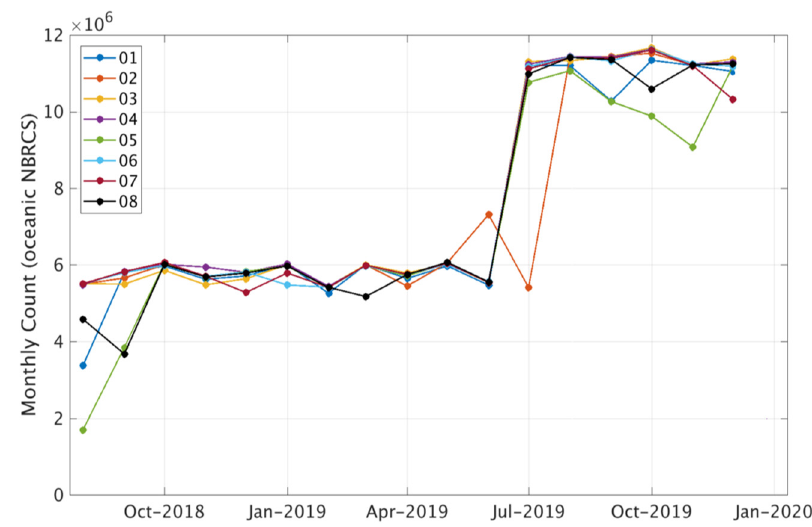
Figure 1. Temporal availability of CyGNSS records by flight model (FM01-FM08).